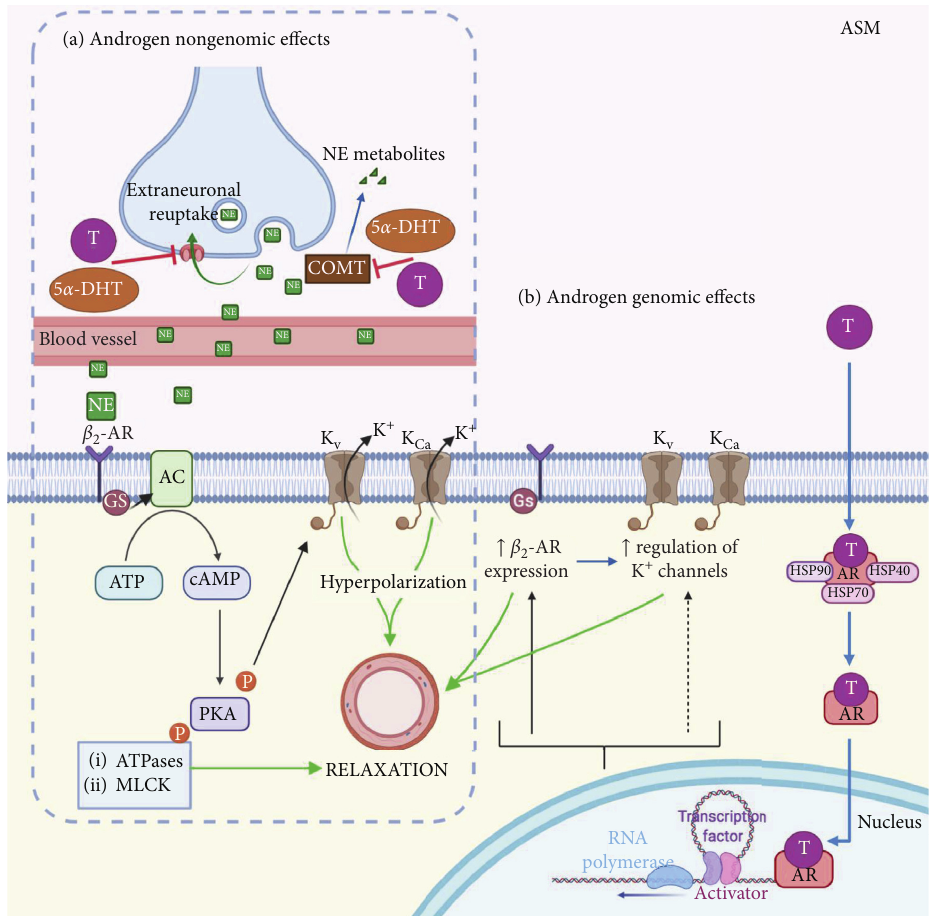
Figure 3: Androgen effects on the adrenergic system in the airway smooth muscle (ASM). (a) Testosterone (T), through a nongenomic effect, potentiates the relaxation induced by the β 2 -adrenergic agonist through the inhibition of catechol-O-methyl transferase (COMT) or by the abolition of extraneuronal uptake of catecholamines. The inhibition of these mechanisms by Tor 5 α -dihydrotestosterone (5 α -DHT, a reduced metabolite of T) leads to the accumulation of catecholamines such as norepinephrine (NE). The β 2 -adrenergic agonist activates adenylyl cyclase (AC), leading to the activation of protein kinase A (PKA), which phosphorylates K + channels, ATPases, and myosin light- chain kinase (MLCK). These targets promote the relaxation of the ASM. (b) The androgen receptor (AR) signaling involves androgen crossing the plasma membrane, entering the cytoplasm, dissociation of chaperone proteins, and binding to the AR. Testosterone stimulation increases the β 2 -adrenergic receptor ( β 2 -AR) expression in the guinea pig ASM and upregulates the Ca 2+ -activated K + channels (K Ca ) and the voltage-dependent delayed rectifier K + channels (K V ). K Ca are activated by increases in intracellular Ca 2+ and through the cAMP-PKA signaling pathway. In the ASM, the main K + channels are the Ca 2+ -activated K + channels of high conductance (BK Ca ). The K V channel subtypes characterized in the ASM are K V 1.2 and K V 1.5. T (nongenomic and genomic effects) favors the relaxation of the ASM and might contribute to decreasing asthma